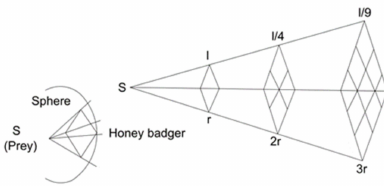
Figure 1. Prey location map (Inverse square law).